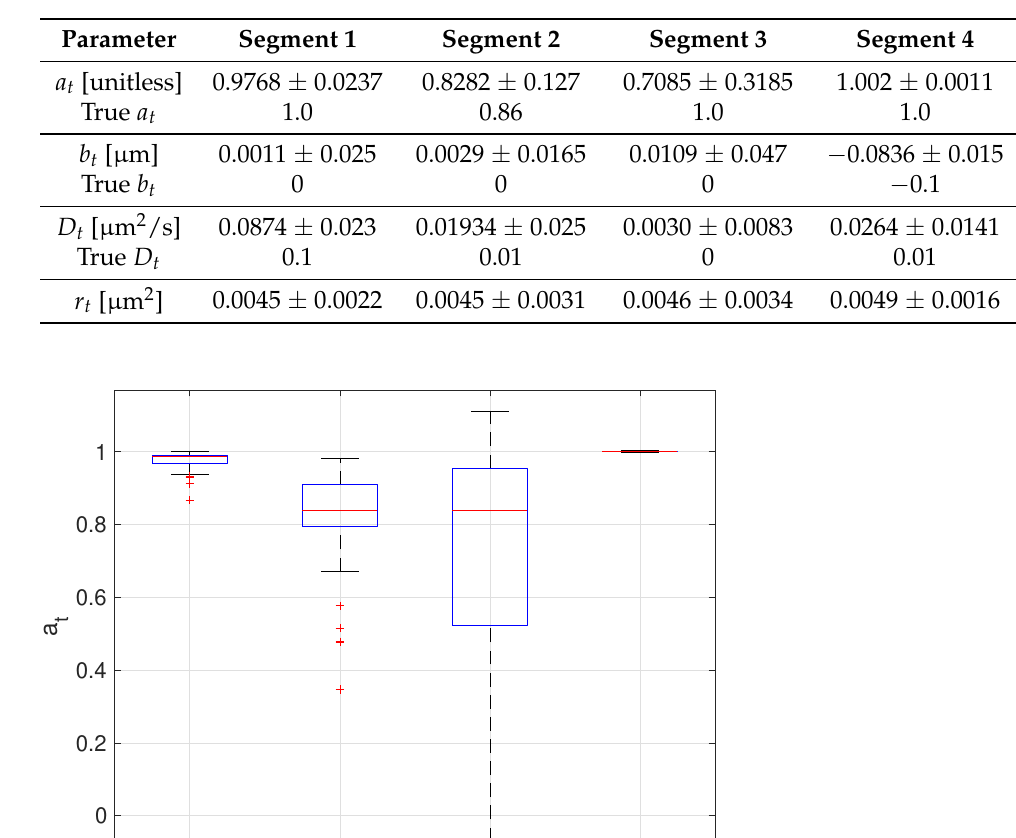
Table 3. Mean and standard deviation of the motion parameter values in each segment over the 64 trajectories with 3 detected changes, together with the true values.